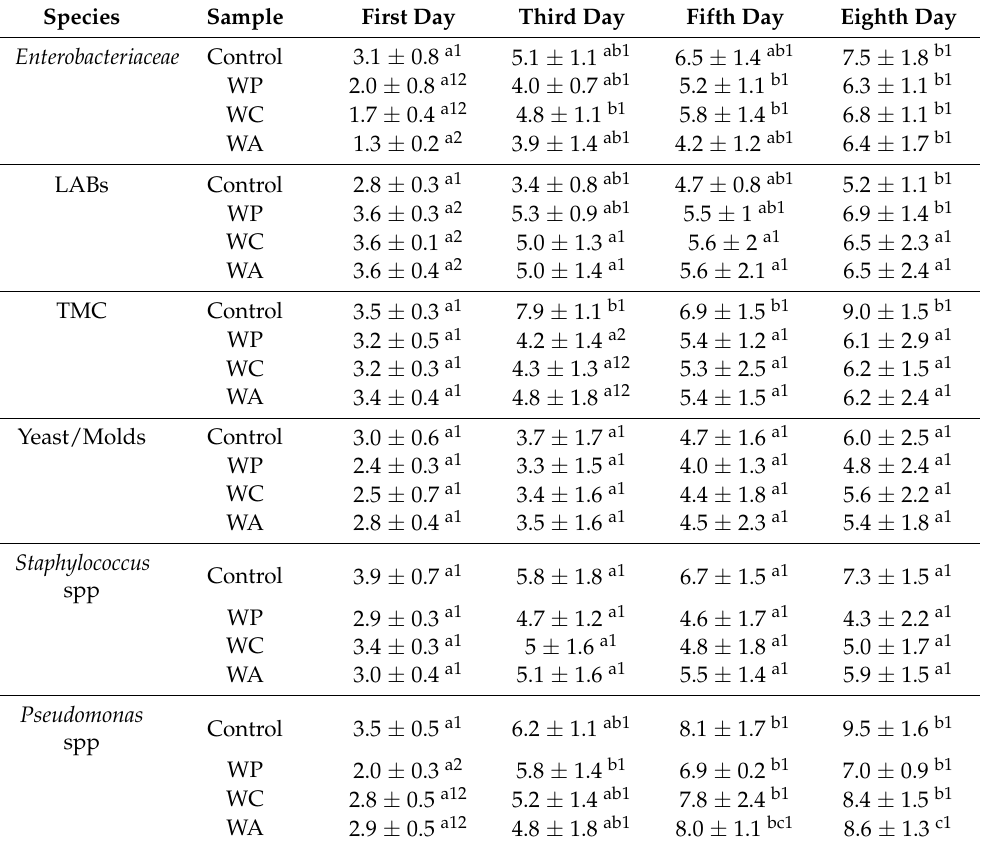
Table 6. Bacterial populations of raw meatballs during the period of cold storage according to the aqueous extract used as a preservative (WP: pomegranate, WC: cranberry, WC: black chokeberry). Species Sample First